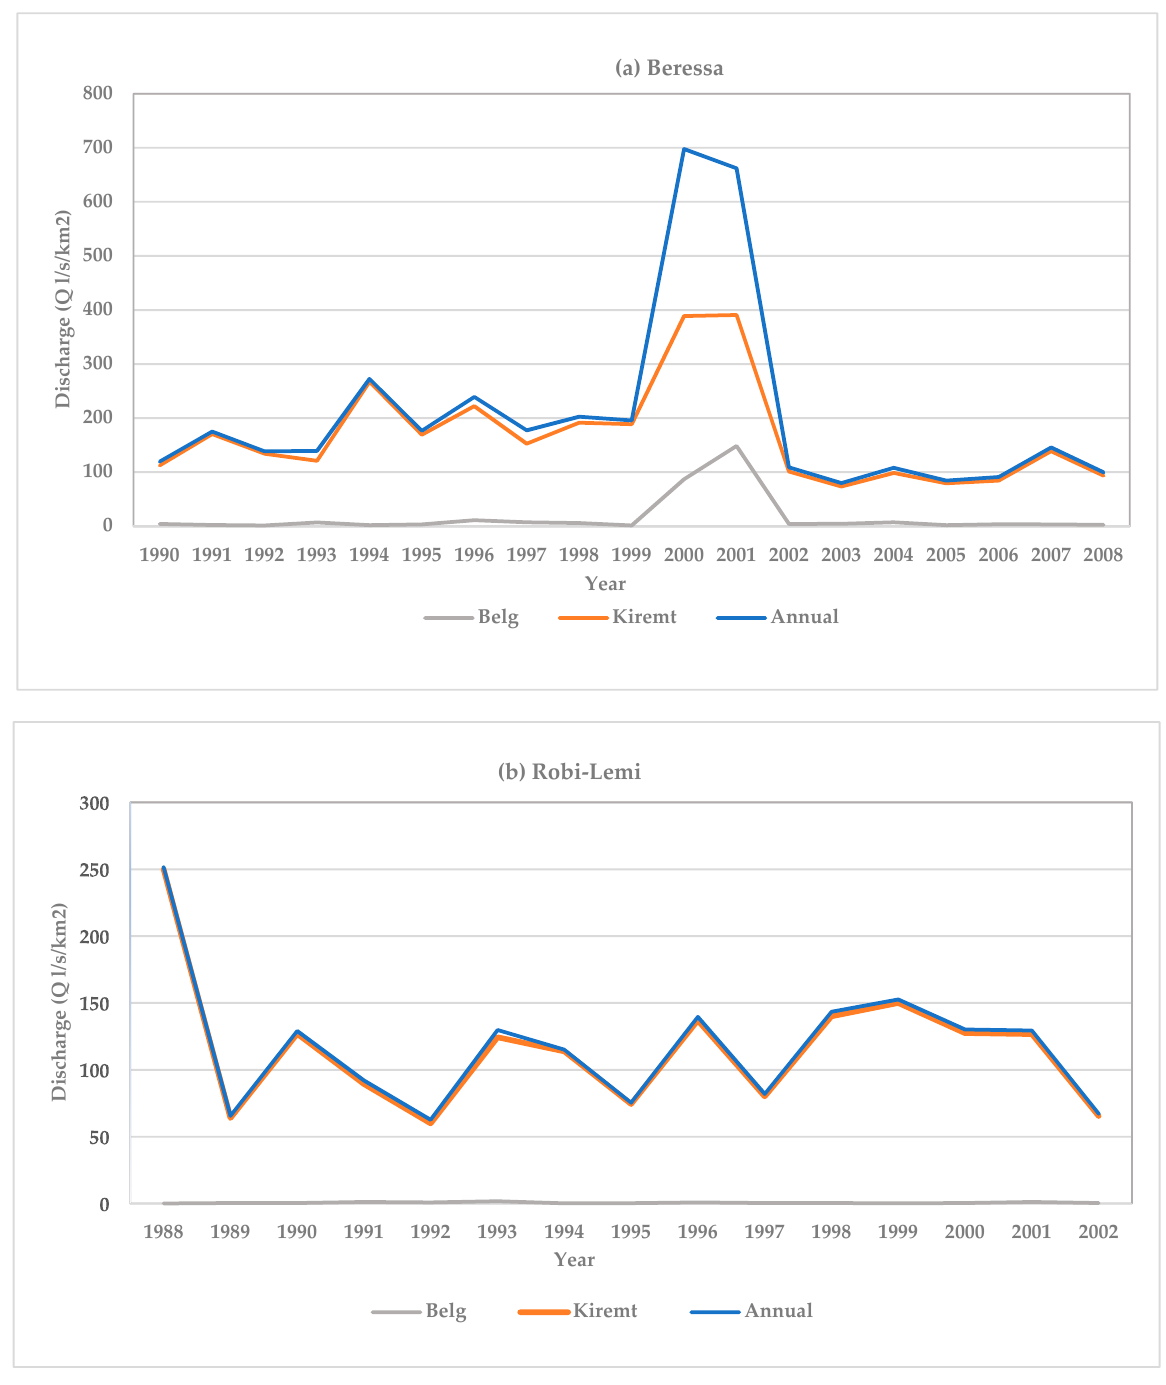
Figure 11. Temporal variations in annual and seasonal stream flow at ( a ) Beressa and ( b ) Robi-Lemi .